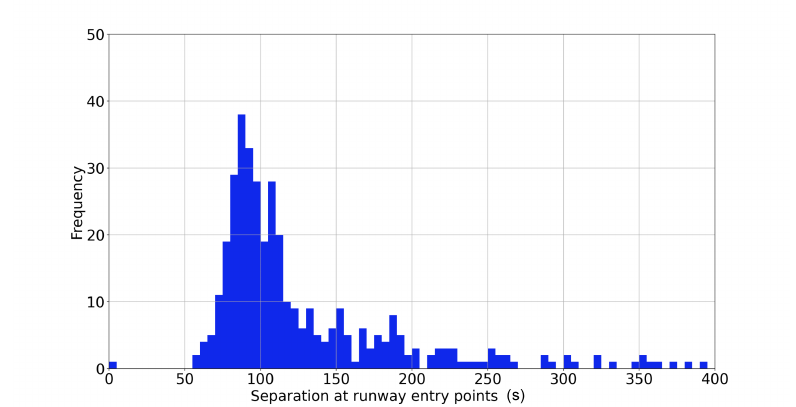
Figure 11. Separation time at runway entry points.